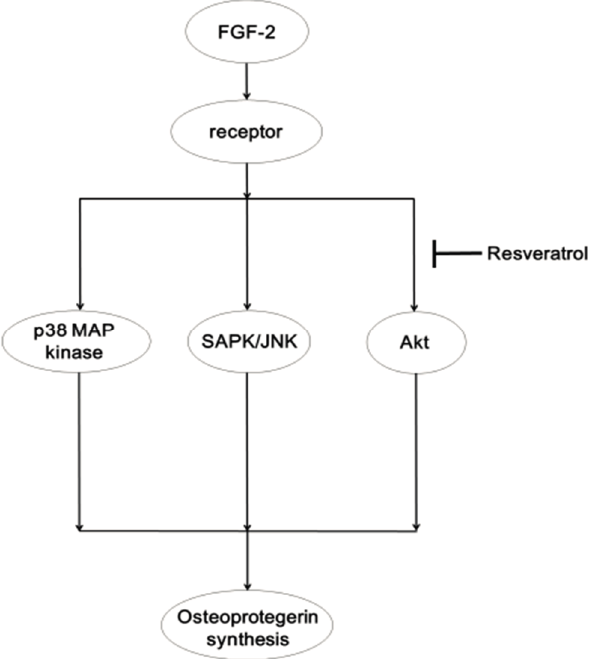
Figure 6. Schematic illustration of the regulatory mechanism of resveratrol on the FGF-2-induced osteoprotegerin synthesis in osteoblast-like MC3T3-E1 cells. Resveratrol reduces FGF-2-induced osteoprotegerin synthesis by inhibiting the Akt pathway without affecting p38 MAP kinase or SAPK/JNK and functions at a point upstream of